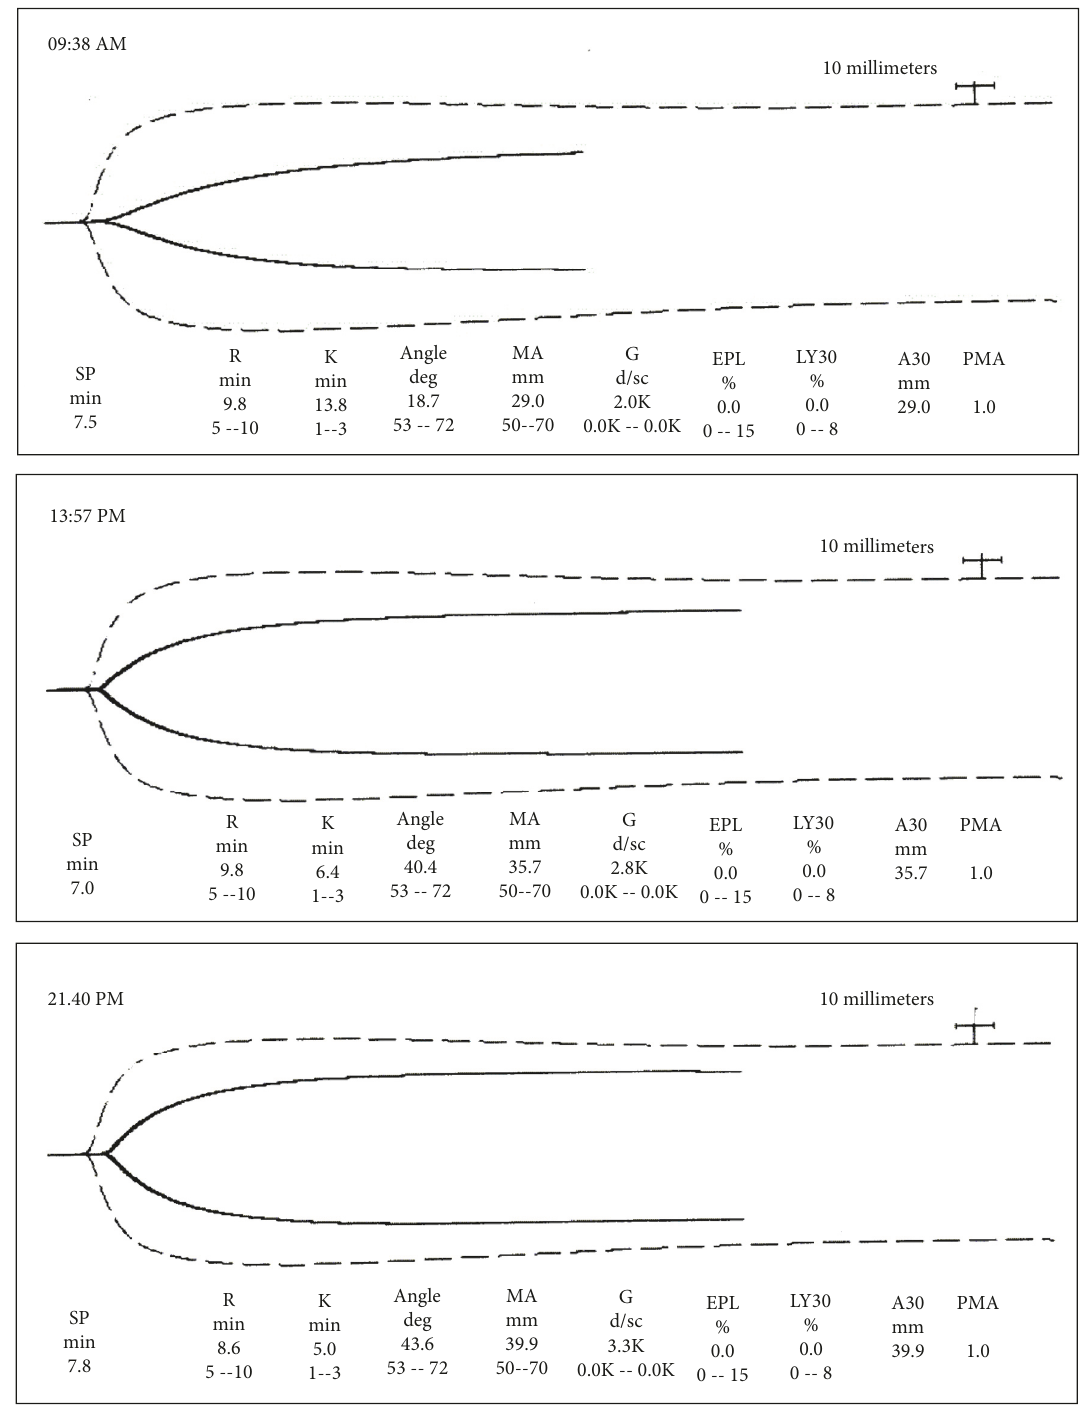
Figure 1: Thromboelastograms (TEGs) before cesarean delivery, after blood replacement therapy, and approximately 12 hours after cesarean delivery. Legend: 09:38 TEG prior to cesarean delivery, note decreased maximum amplitude, elevated K value, and decreased alpha angle; 13:57 TEG after blood replacement therapy, note K value, alpha angle, and maximum amplitude improving but still below normal; 21:40 TEG later that evening, below normal